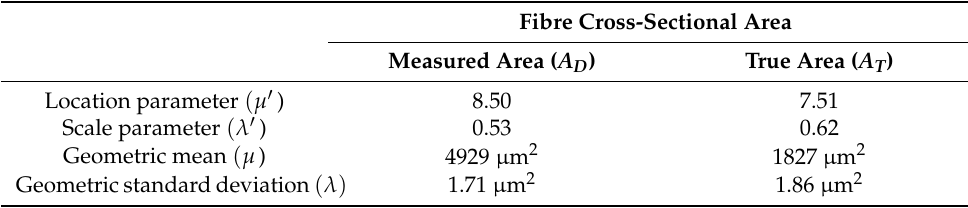
Figure 7. Log-normal distributions of measured and true cross-sectional areas of flax technical fibres. Table 2. Location parameter, scale parameter, geometric mean and geometric standard deviation of the measured and true cross-sectional areas of flax technical fibres.